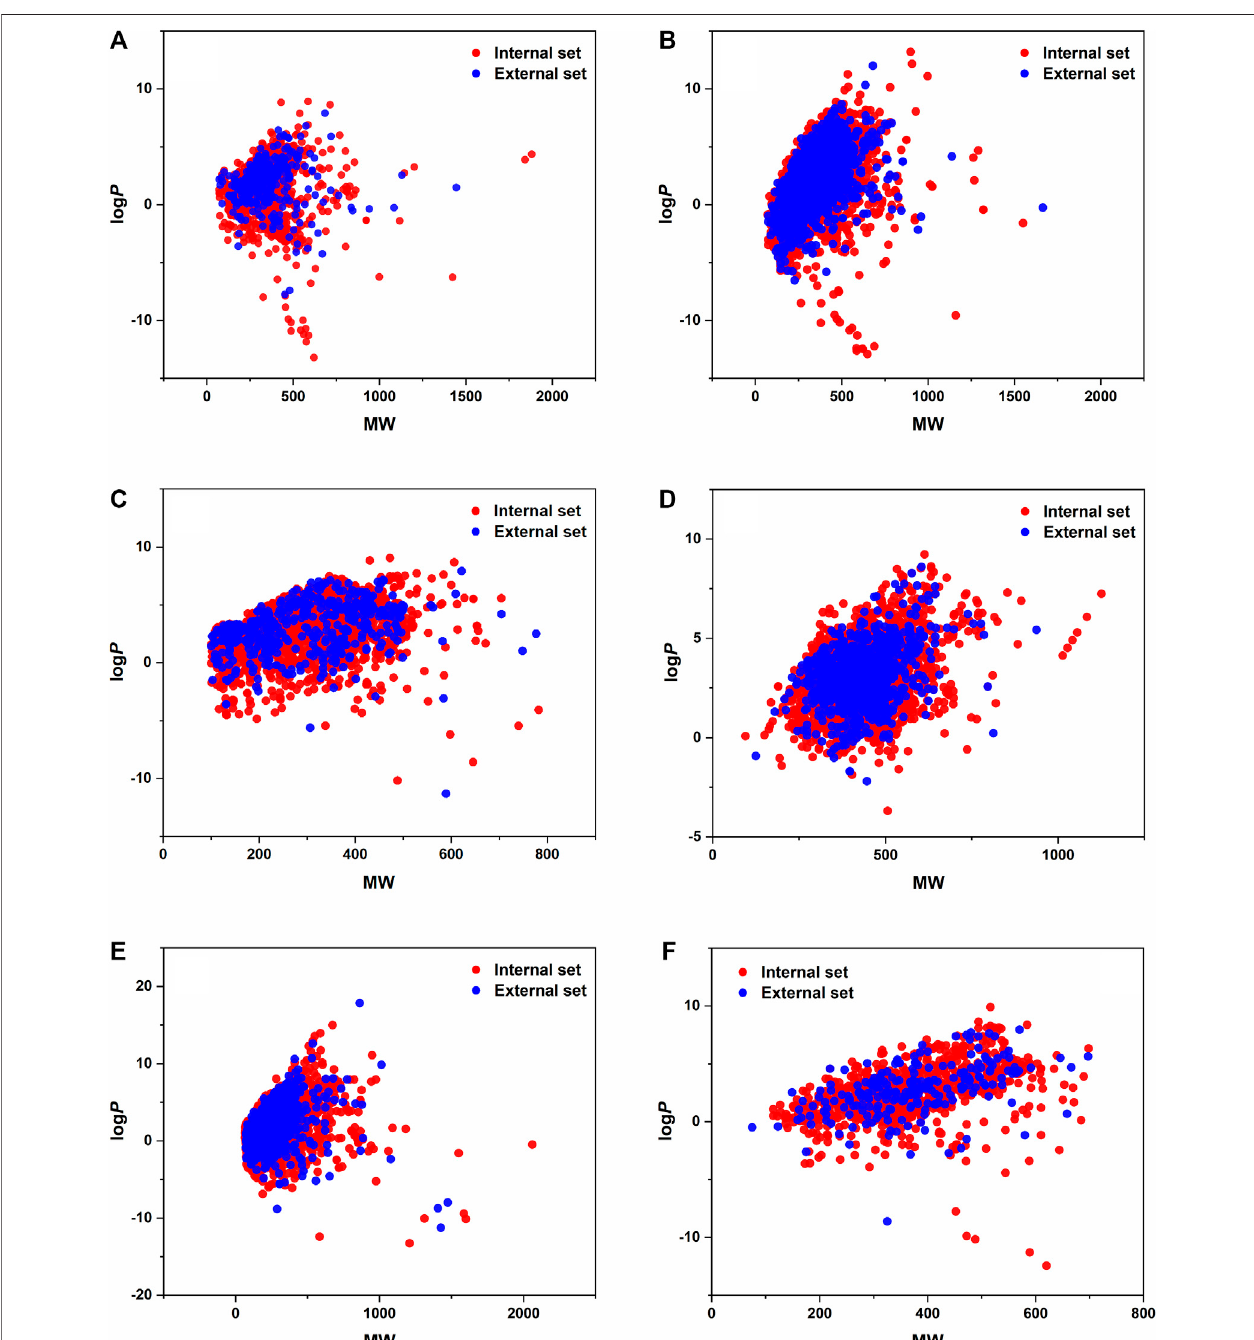
FIGURE 1 | LogP values are plotted against the MW of the molecules for each dataset, internal and external sets separately. (A) BBB, (B) CYP 2C9, (C) hepatotoxicity, (D) hERG, (E) mutagenicity, and (F) P-glycoprotein datasets.